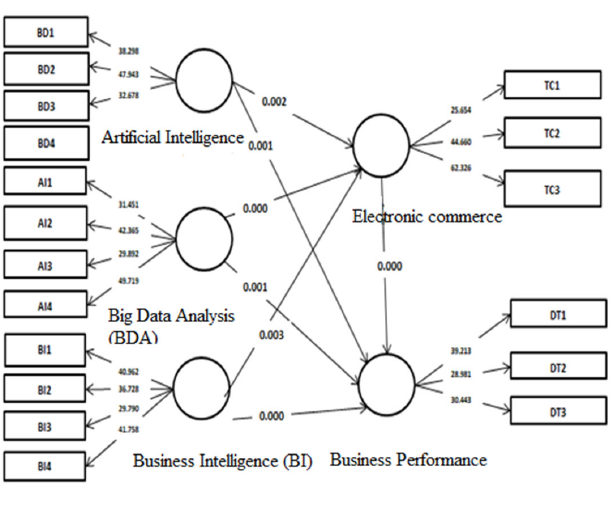
Fig. 2. The results of bootstrapping